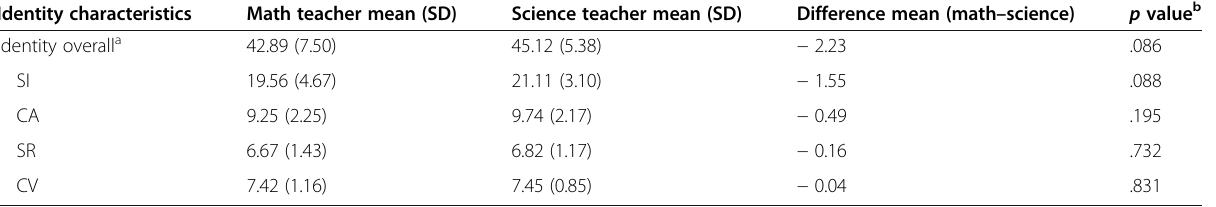
Table 4 Differences in science and math teacher identity characteristics by the mean Identity